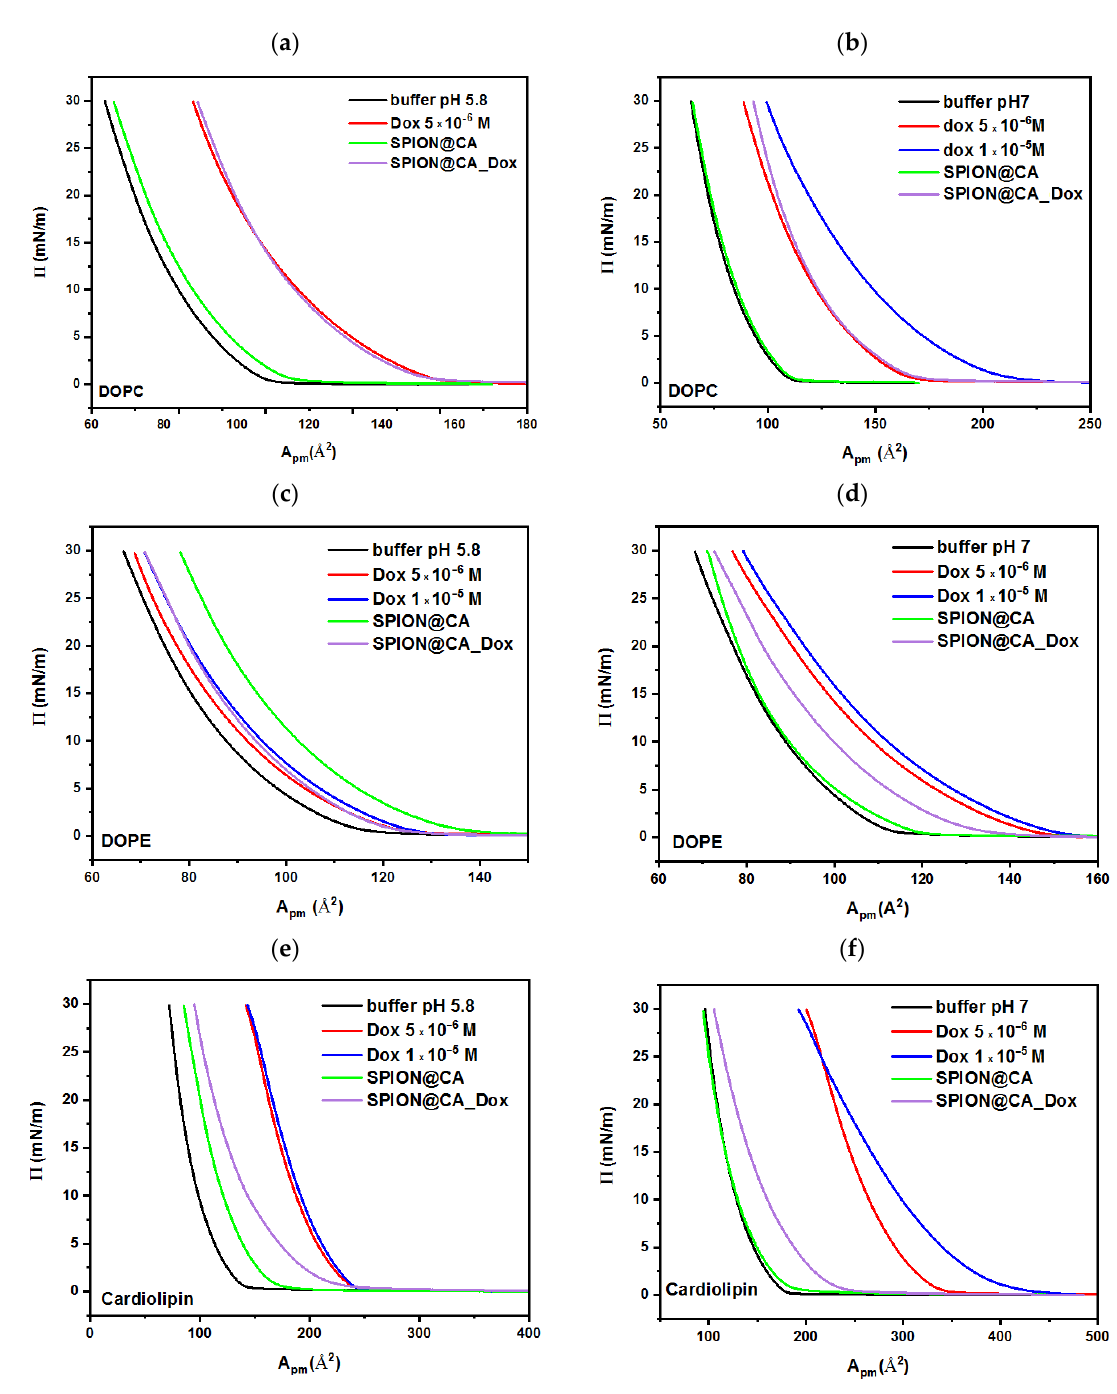
Figure 6. Langmuir isotherm for lipid ( a , b ) 1,2-dioleoyl-sn-glycero-3-phosphocholine (DOPC), ( c , d ) 1,2-dioleoyl-sn-glycero-3-phosphoethanolamine (DOPE), and ( e , f ) cardiolipin on phosphate buffer as a subphase with the addition of doxorubicin at two different concentrations, SPION@CA, and SPION@CA_Dox. The left column shows the results obtained at pH 5.8, while the right column presents the isotherms recorded at pH 7.